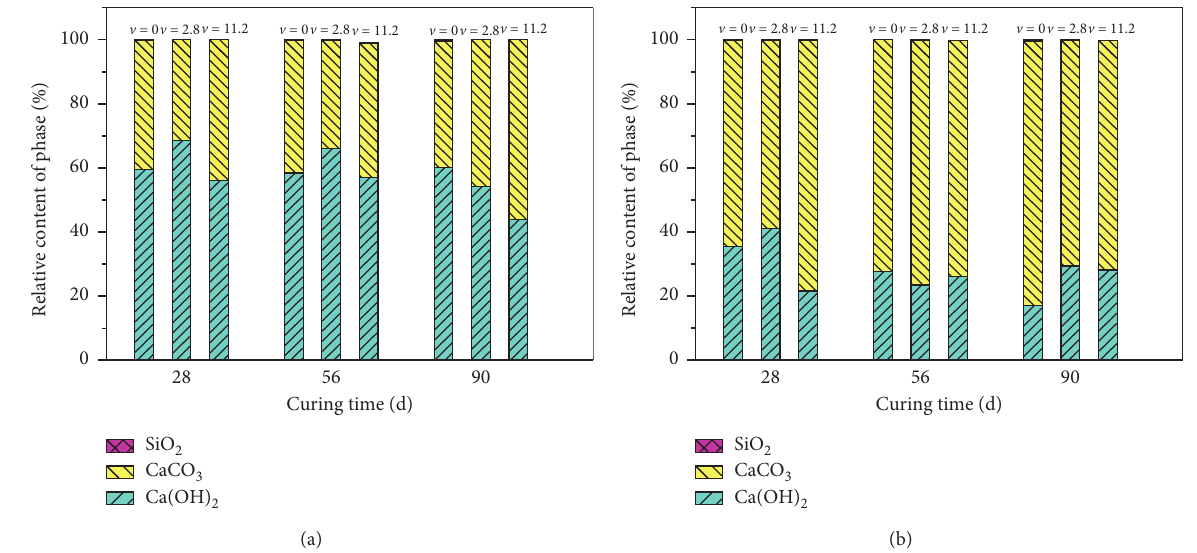
Figure 8: Quantitative analysis of phase mass fraction by XRD-Rietveld for specimens of different ages: (a) OPC; (b) SMC.